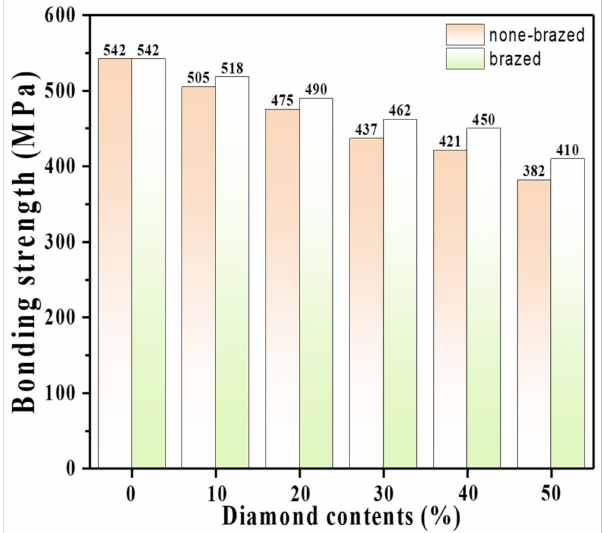
Figure 24. Cross-section ( a ) and surface ( b ) morphology of TiC compound on diamond particle. Reprinted with permission from Ref. [57]. Copyright 2013, Elsevier.